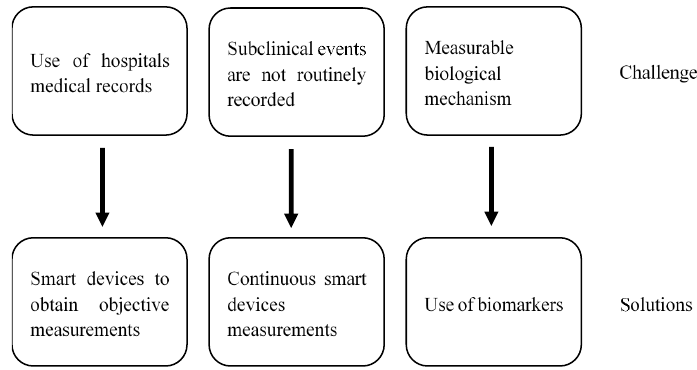
Figure 2. Outcome assessment challenges and their novel solutions.